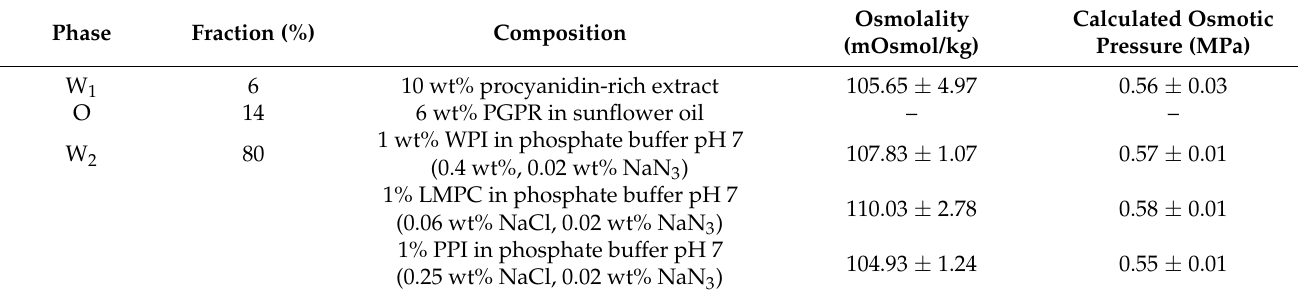
Table 1. Formulations of W 1 /O/W 2 emulsions and osmotic properties of aqueous phases. Phase Fraction (%) Composition